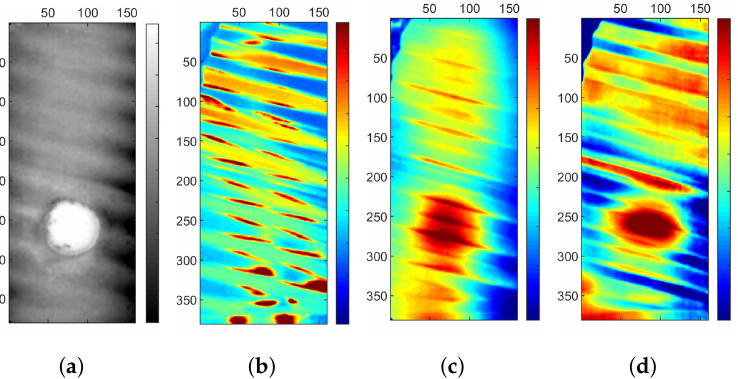
Figure 12. LPT analysis; Experiment 3. ( a ) LPT with no specimen. ( b ) LPT with original specimen 2. ( c ) LPT with painted (flat) specimen 2. ( d ) PCT for painted (flat) specimen 2. The same cavity configuration was used for ( a – d